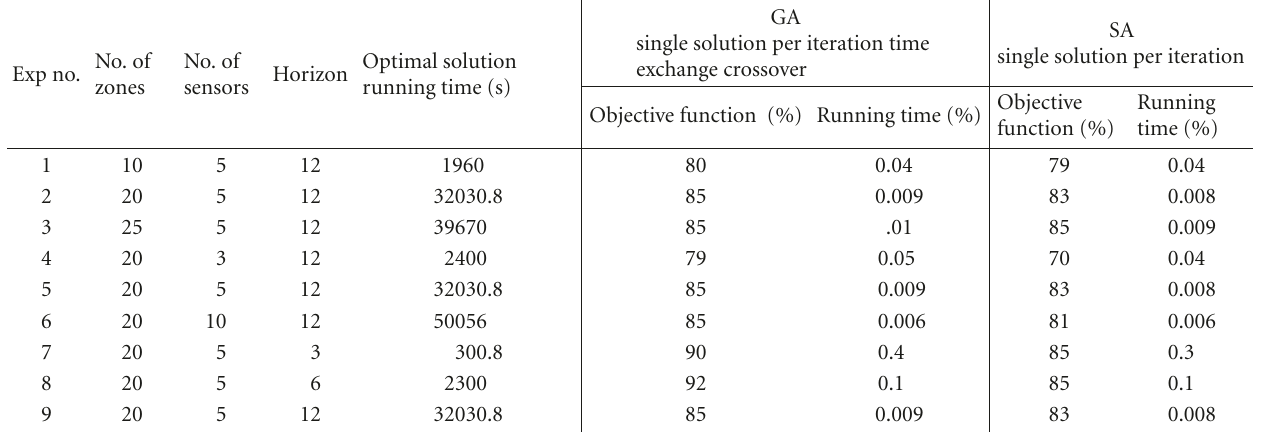
Table 1: Performance of the GA and SA algorithms compared to the optimal